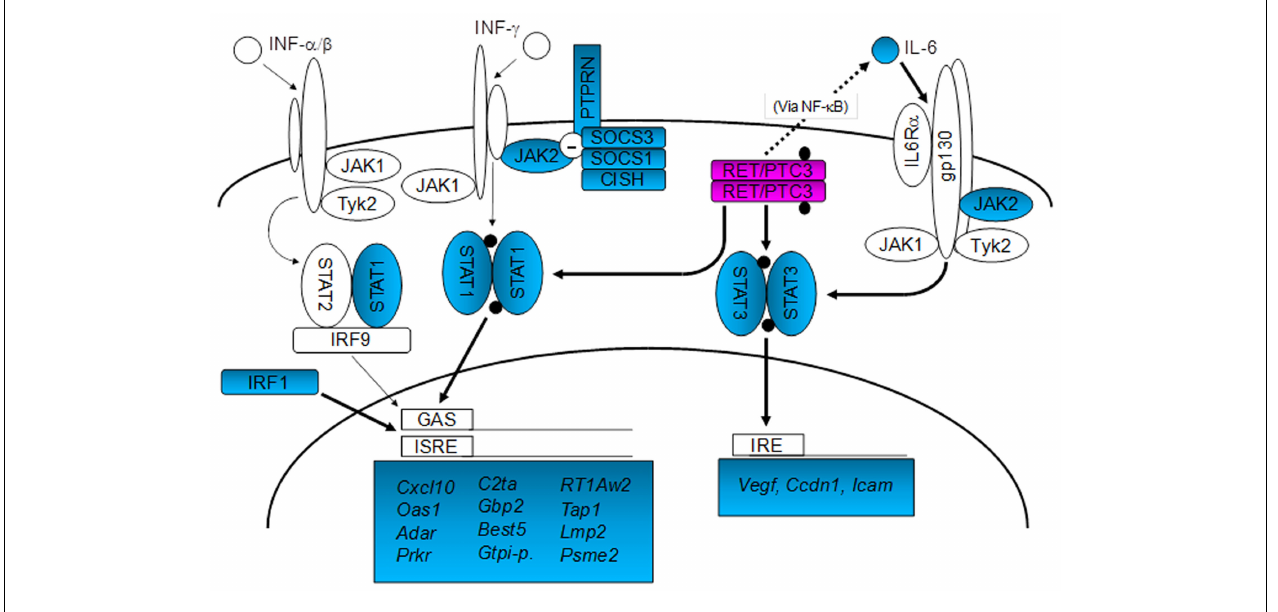
2003, 2004) and through increased IL-6 expression, possibly via NF-kB (Wixted et al., 2011) (STAT3 activation). In addition RET/PTC3 induces the expression of additional components of these two pathways, such as JAK2, SOCS1 and 3, CISH and PTPRN. RET/PTC3-induced activation of STAT1 results in the up-regulation of IFN-responsive genes, whereas activation of STAT3 results in the up-regulation ofVEGF, Cyclin D1, and ICAM (Hwang et al., 2003; modified from Puxeddu et al. (2005a) with permission of Bioscientifica